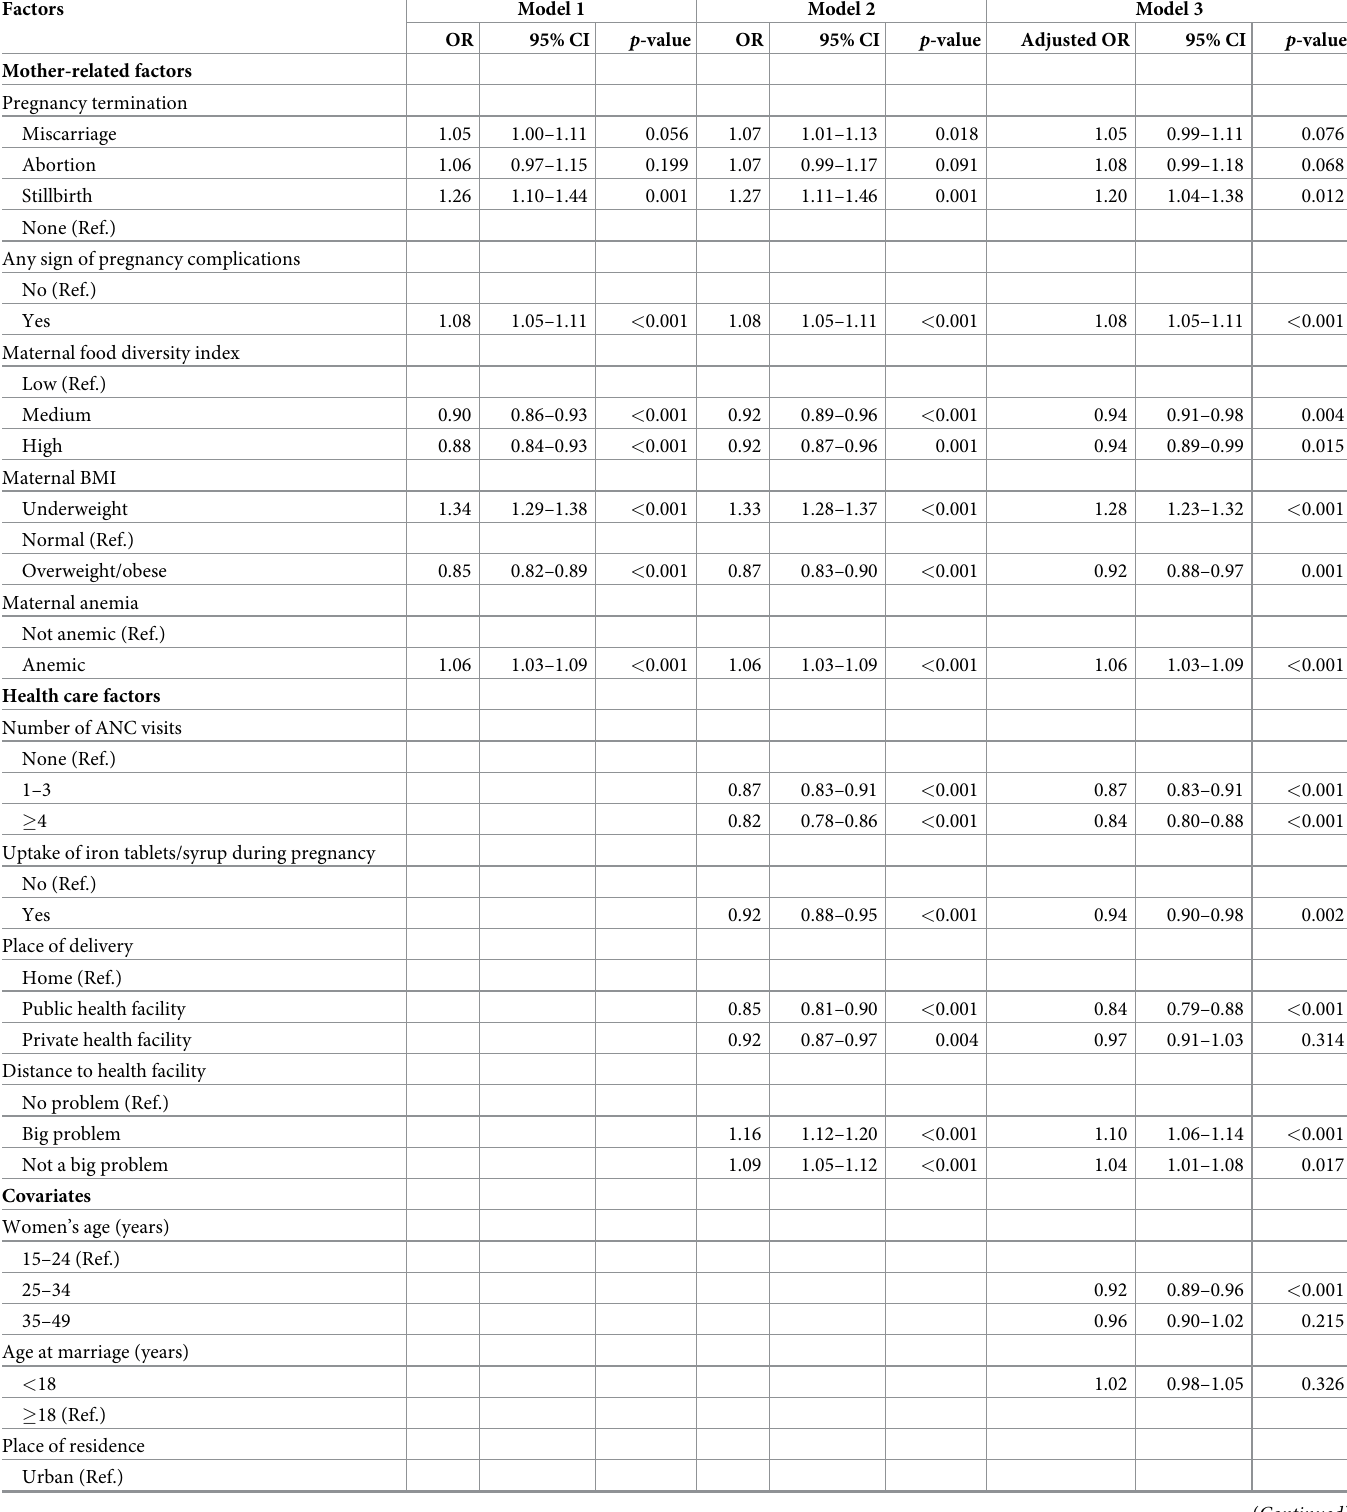
Table 2. Maternal factors associated with low birth weight of children in India,